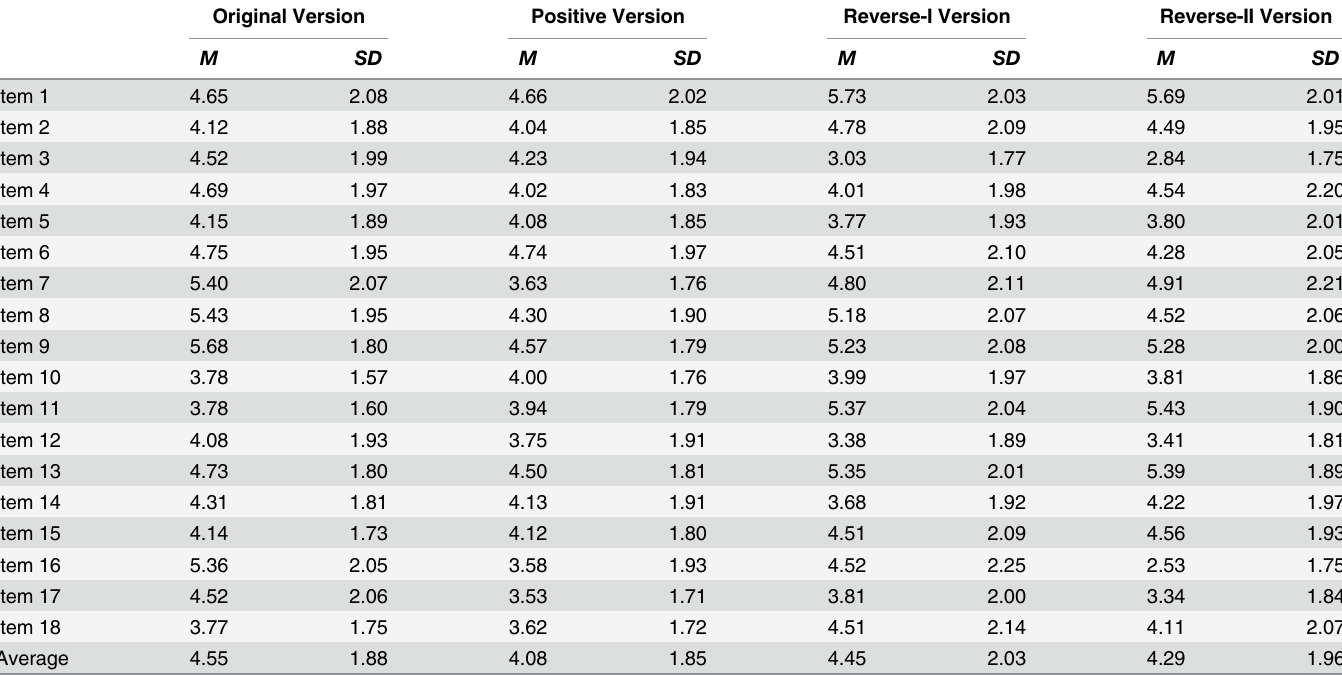
Table 2. Descriptive Statistics for all versions of Need for Cognition (NFC)